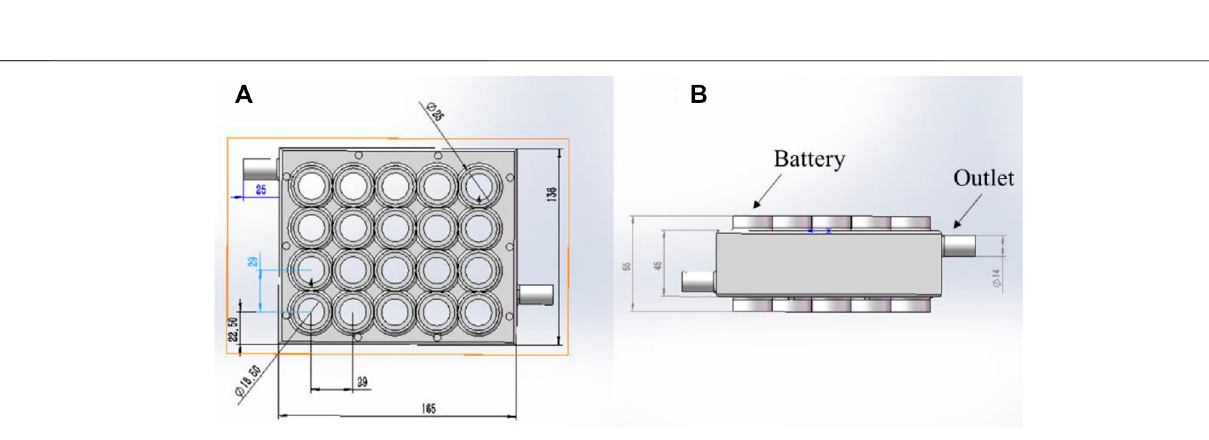
FIGURE 2 | The structure of the 5s4p battery pack: (A) planform; (B) side view.